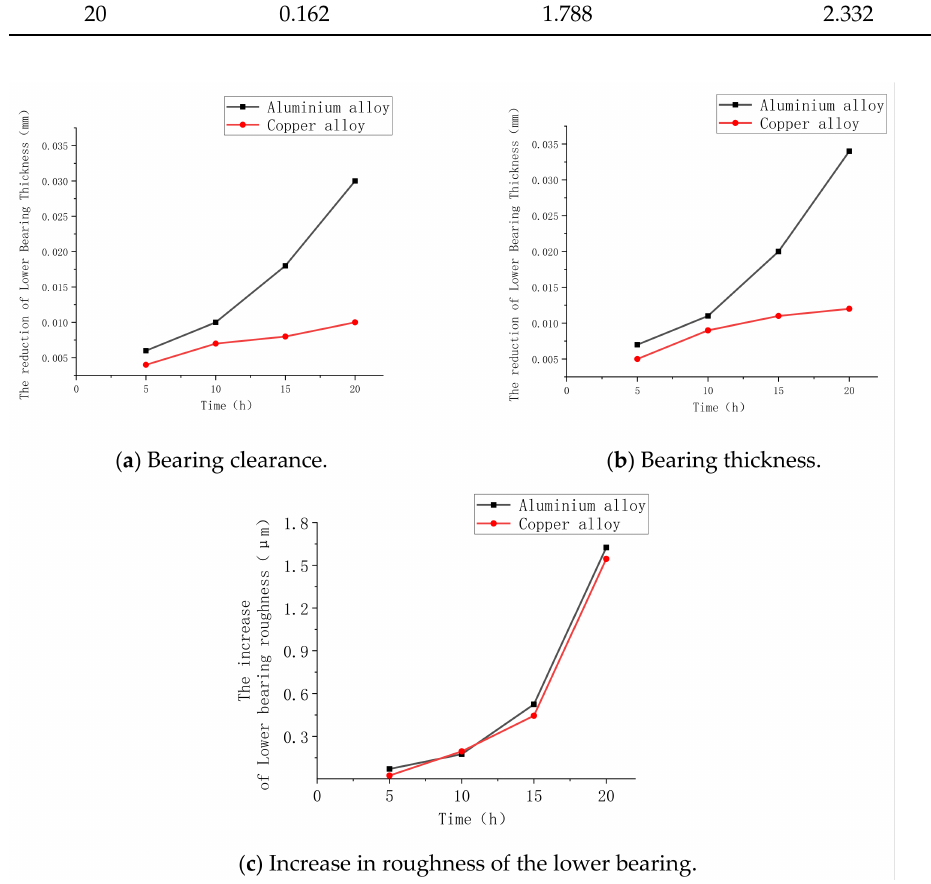
Figure 12. Bearing wear at different wear test